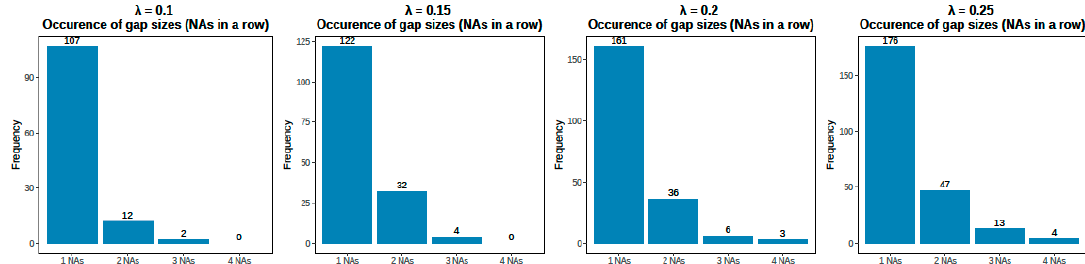
Figure 6. Distribution of simulated missing data.